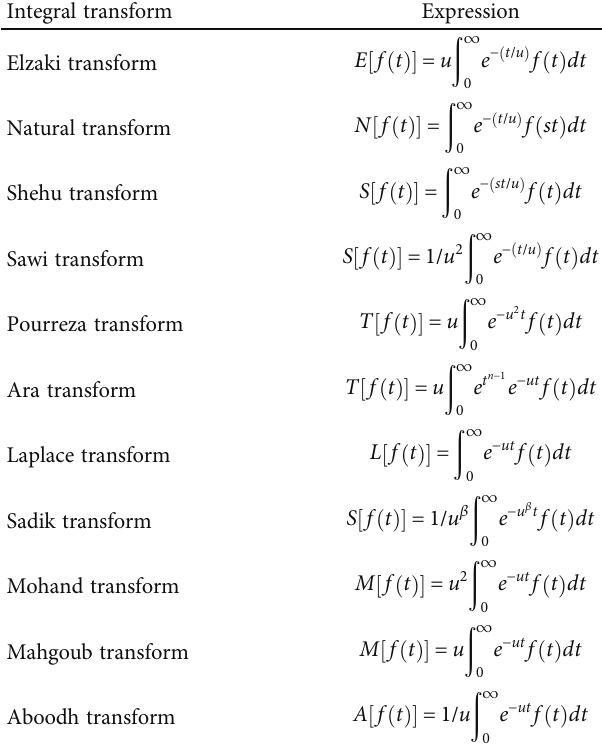
Table 1: Some known integral transforms [17, 22, 36]. Integral transform